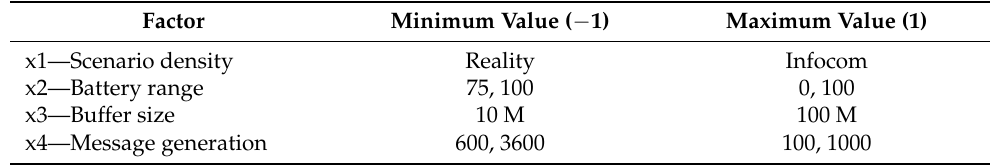
Table 2. Factors of experiments.